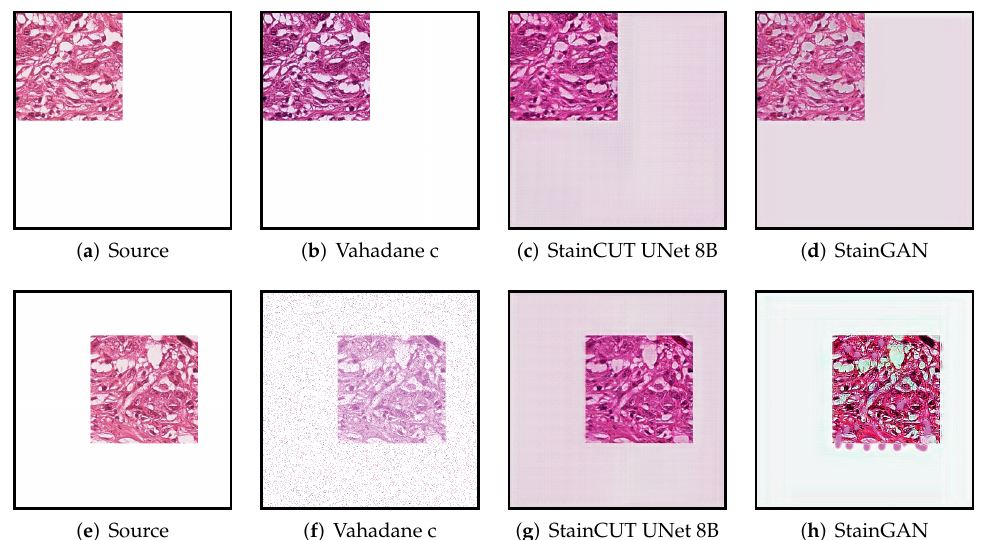
Figure 14. Example of applying the stain transfer (trained with the MITOS-Atypia dataset) to two out of distribution images. In the training dataset, all images were full of tissue. We have taken one of those images and made three quarters of it white. In the first case ( top row ), the result when applying the Vahadane method appears to be consistent; however, the StainCUT and StainGAN methods introduce a pink color in the white area. In the second case ( bottom row ), the StainCUT has a similar problem; however, Vahadane introduced some noise, and StainGAN produced some artifacts.